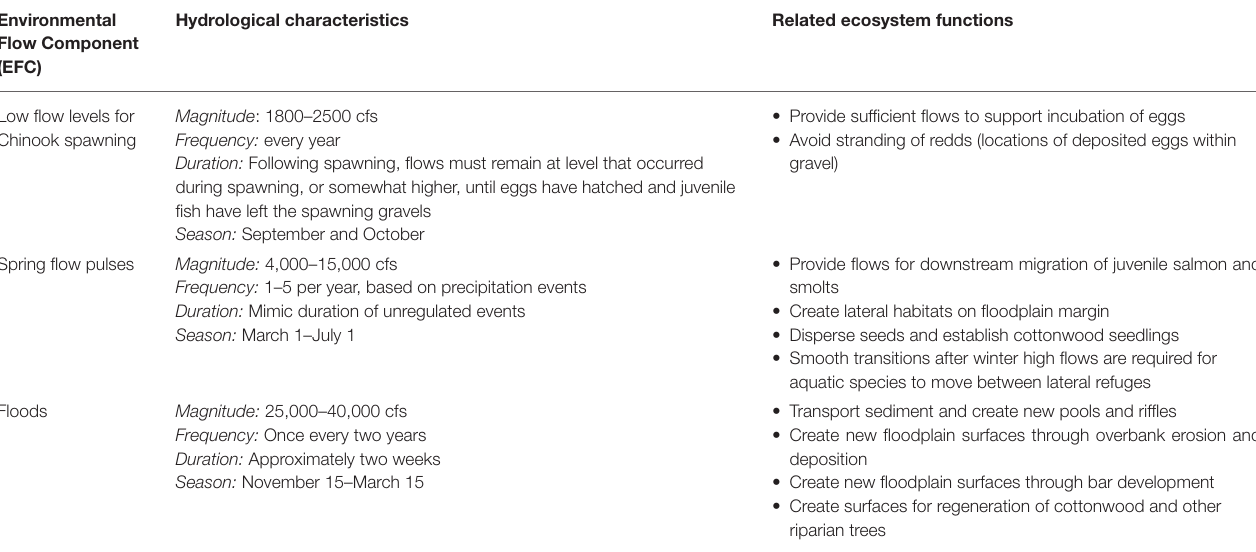
TABLE 3 | A sample of the initial flow recommendations from a Level 2 process for the Middle Fork of the Willamette River (Warner et al., 2014). Environmental Hydrological characteristics Related ecosystem Flow Component